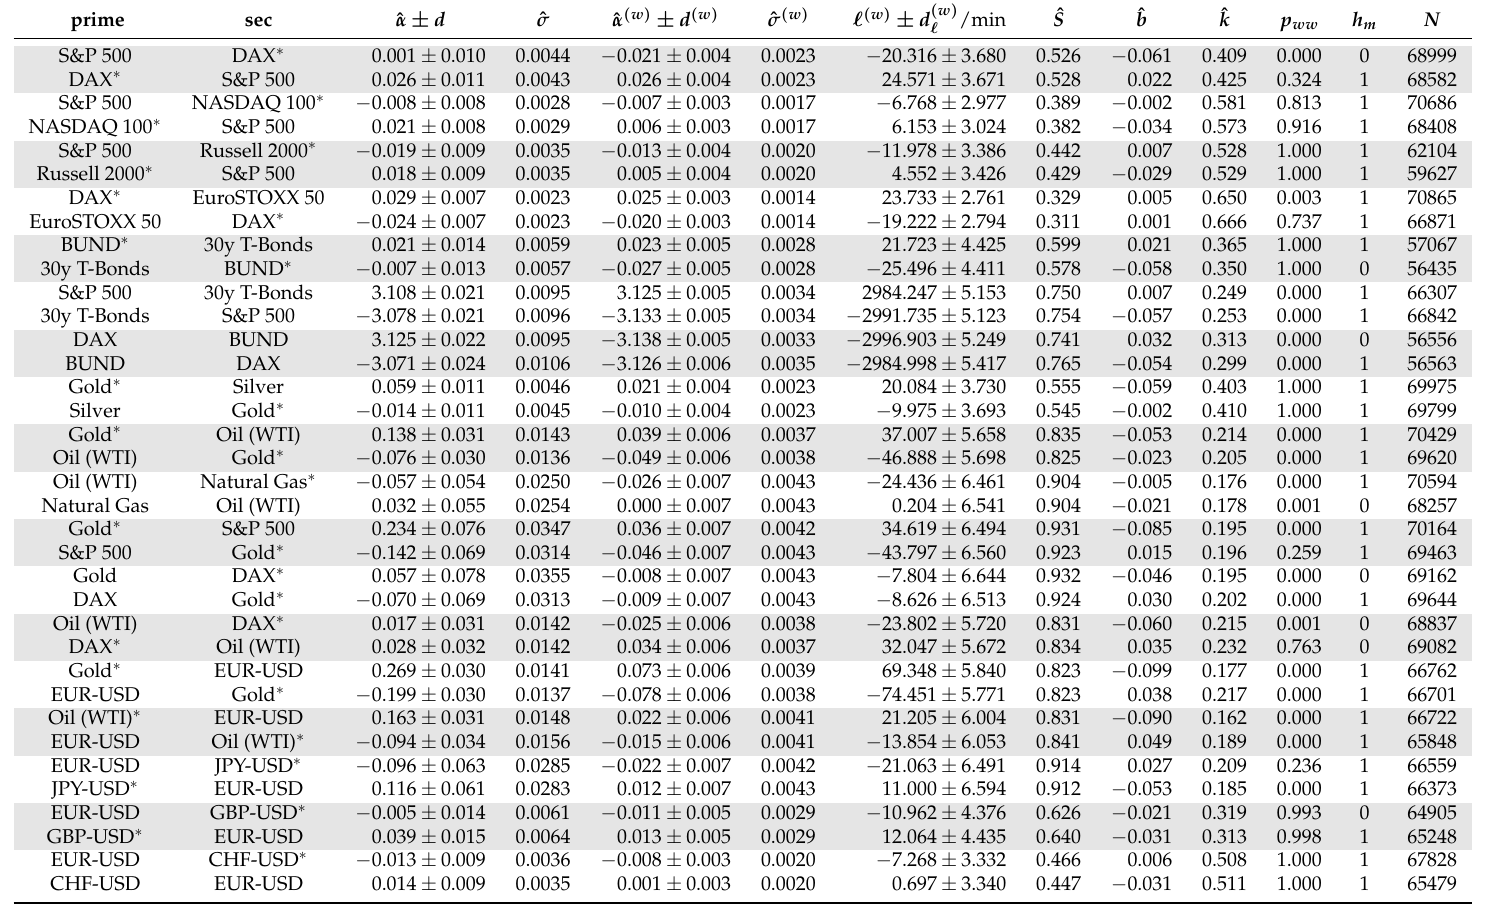
Table 2. Results on 10min chart (time of extrema). ∗ This market leads the other